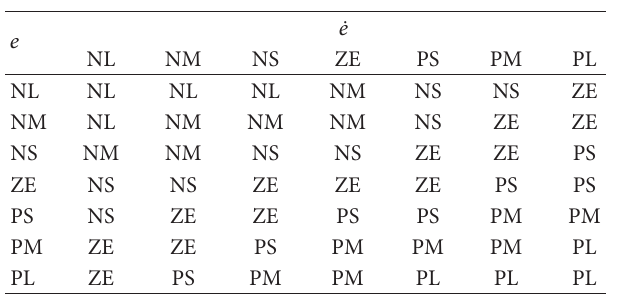
Table 1: Fuzzy rules base.